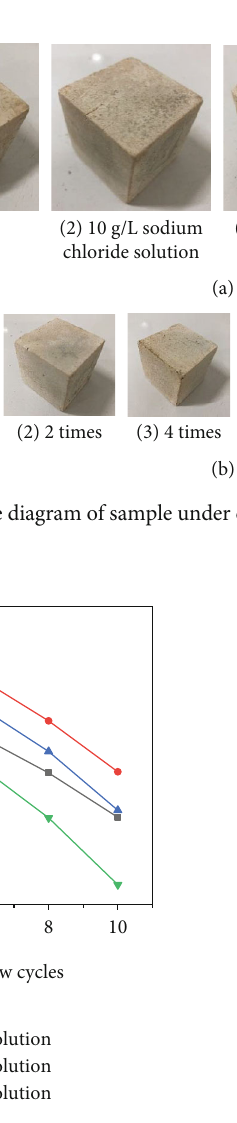
6: Variation of sample mass loss rate with the number of